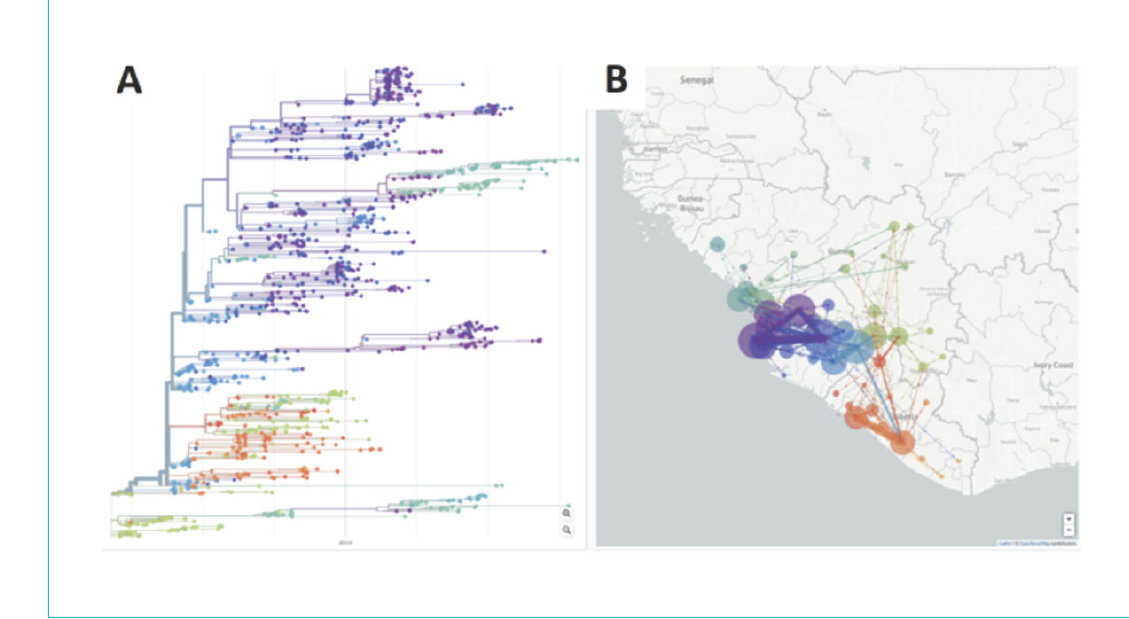
Figure 1: NextStrain tool to analyse transmission of pathogens. (A) Phylogenetic tree of the Ebola virus outbreak in West Africa. Colours represent different geographic regions, and x-axis reflects a time scale during the outbreak. (B) Transmission dynamics modelled in real-time with new viral strains based on WGS